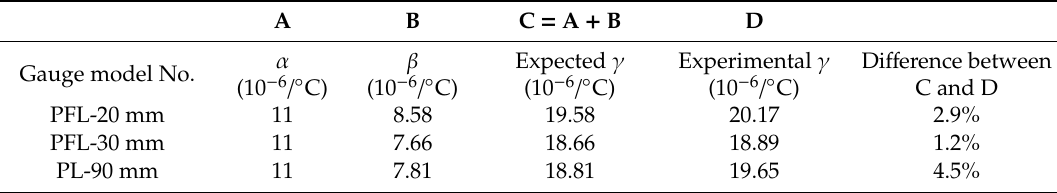
Table 1. Test results for the temperature-resistance e ff ect of the strain gauge attached to concrete. A B C = A + B D α β Expected γ Experimental γ Di ff erence between Gauge model No. (10 − 6 / ◦ C) (10 − 6 / ◦ C) (10 − 6 / ◦ C) (10 − 6 / ◦ C) C and D PFL-20 mm 11 8.58 19.58 20.17 2.9% PFL-30 mm PL-90